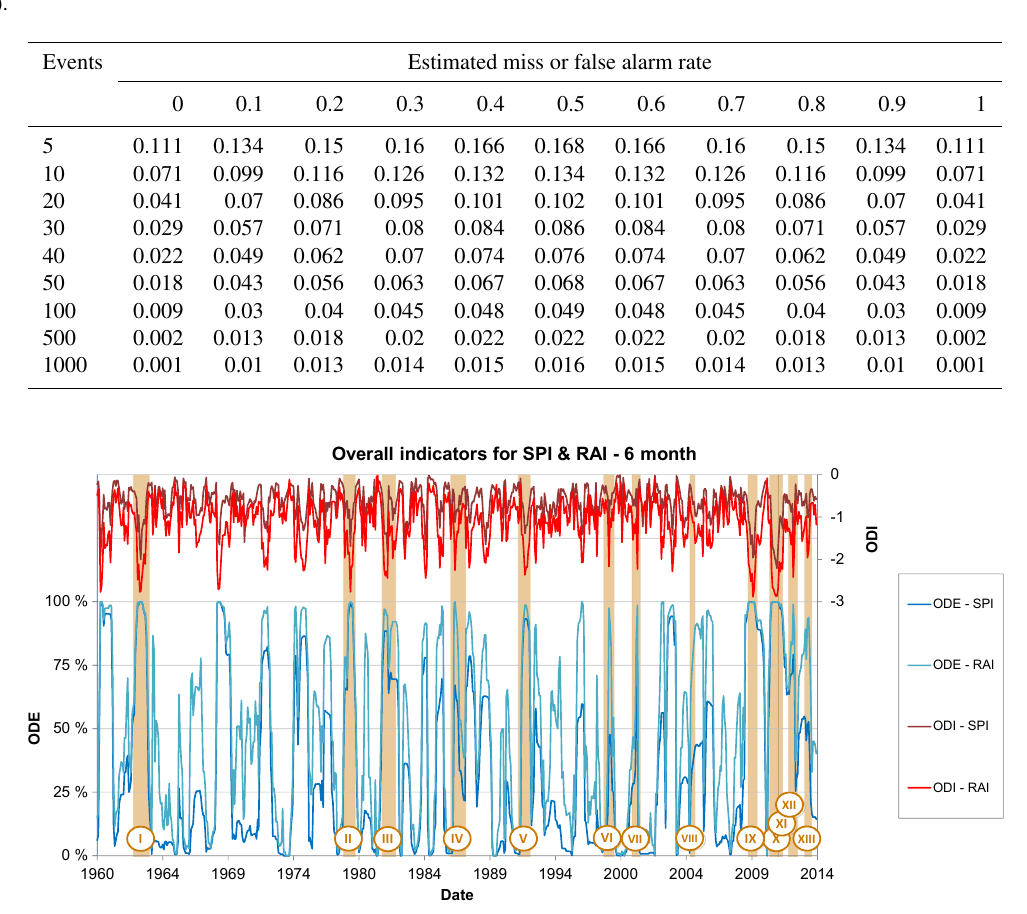
Table 8. Standard error in estimated miss or false alarm rate calculated using the 95% score confidence interval as discussed in Agresti and Coull (1998).